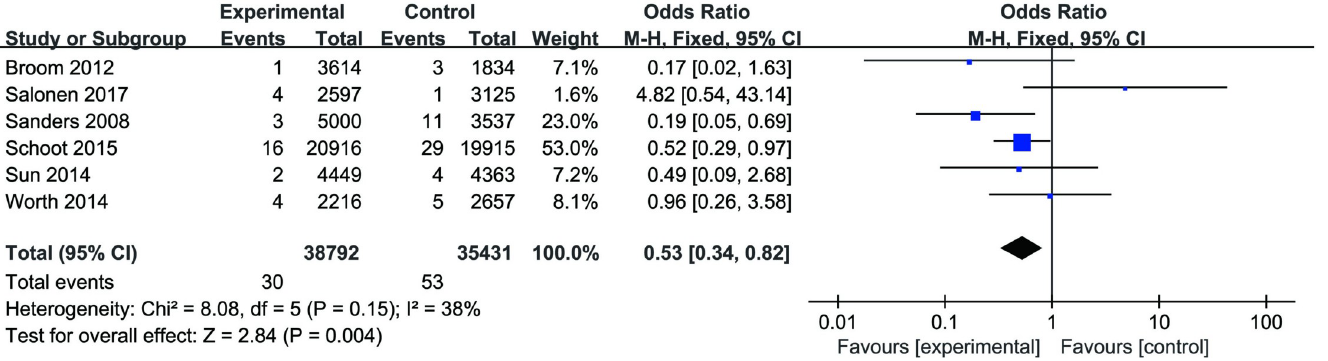
Fig 2. CRBSI per 1000 catheter days for trials that compared ethanol locks with heparin.